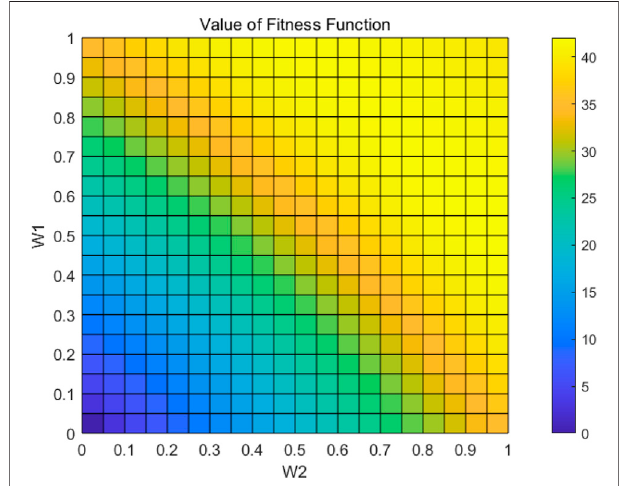
FIGURE 7 | Value of fi tness function with different weights.